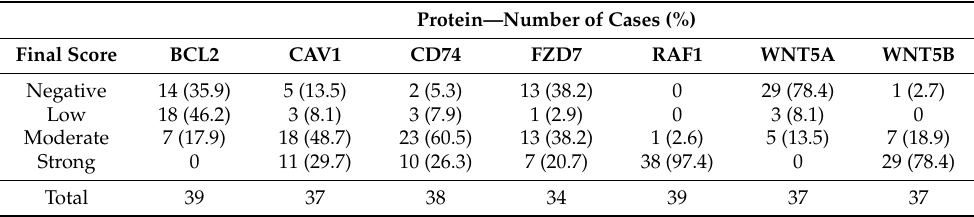
Table 1. Protein expression results obtained in juvenile nasopharyngeal angiofibromas evaluated by